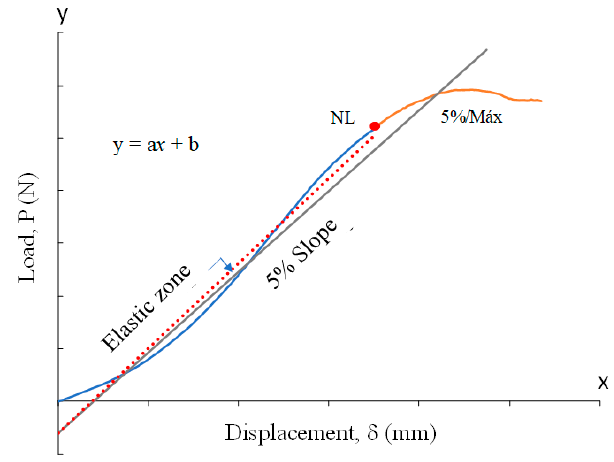
Figure 5. Measurements in raw data plots.